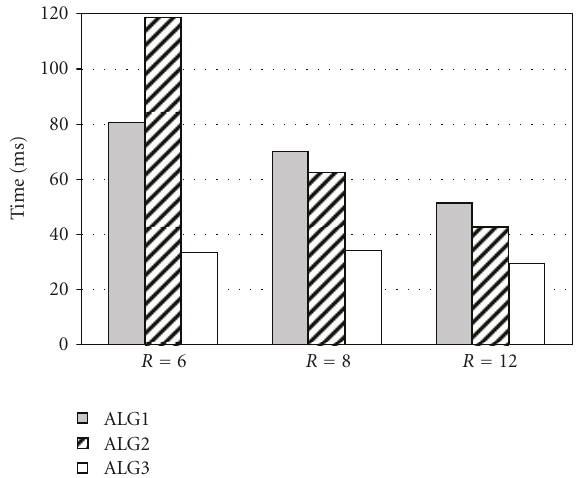
Figure 12: Average time to find five proxies with high connectivity ( P actual = 60%; data rate =